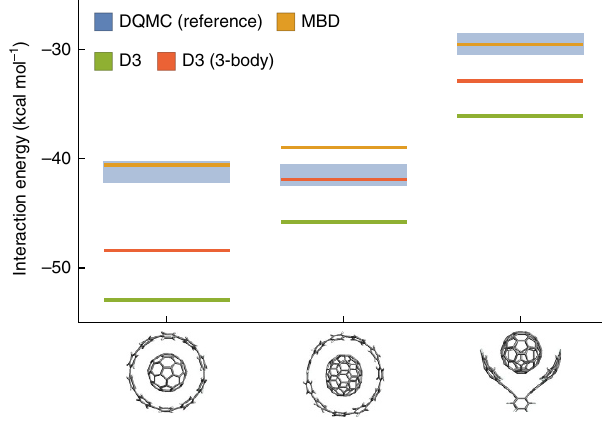
Figure 2 | Interaction energies of complexes C1–C3 (kcalmol (cid:2) 1 ). The energies are evaluated with respect to relaxed fragments (see Supplementary Data 1). DQMC is the reference diffusion quantum Monte-Carlo method 31 . The blue bar indicates the statistical sampling errors in the energy, which are inherent to the method. MBD is the MBD method 19 calculated on top of the PBE exchange-correlation density functional 58 . D3 is the DFT-D3 approach 59 with the optional three-body correction on top of the PW6B95 density functional; the values were taken from refs 23,24. Numerical values are presented in Supplementary Table 1.